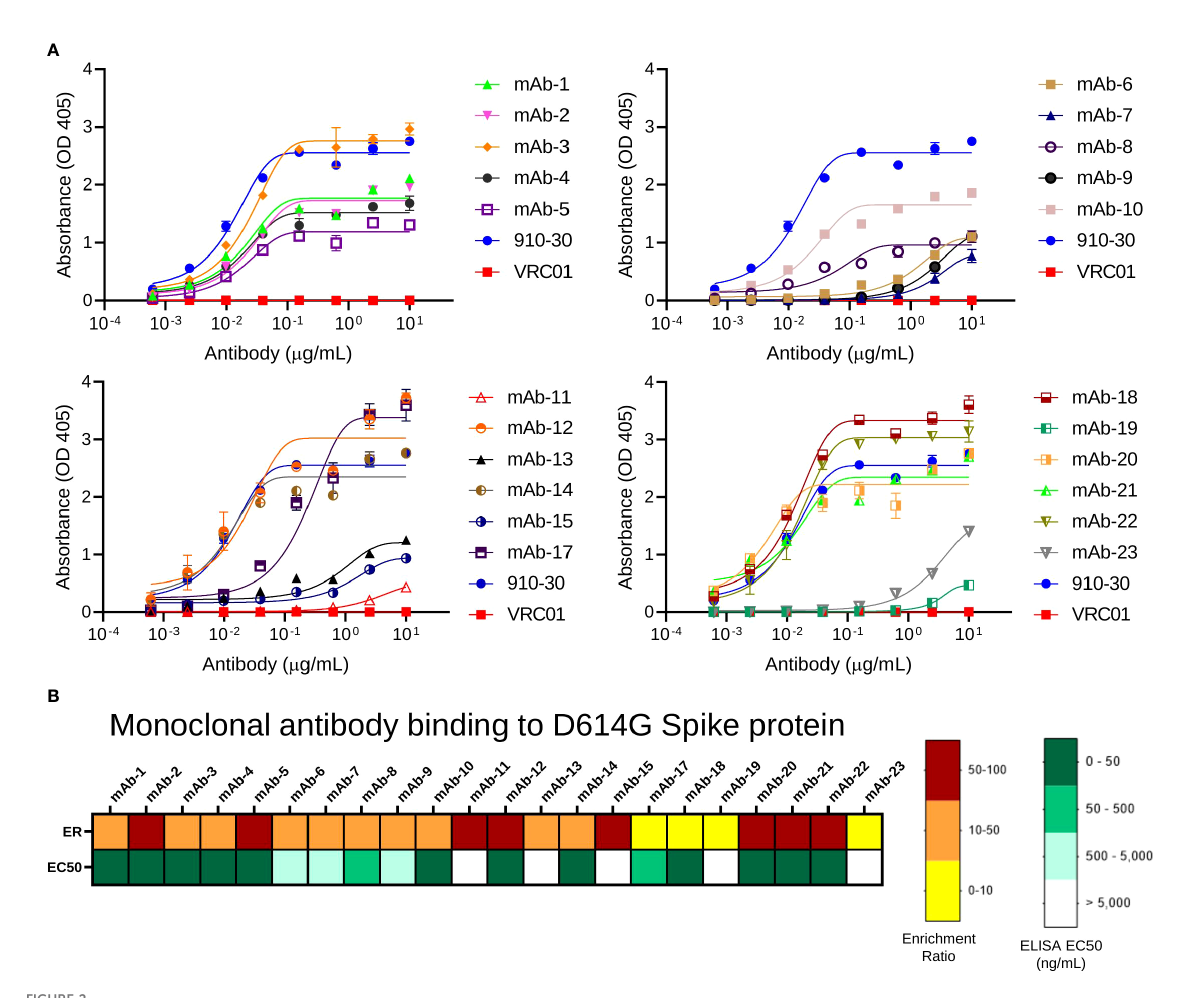
FIGURE 2 Validation of predicted antibody clones by ELISA. (A) ELISA absorbance pro fi les of expressed IgGs to SARS-CoV-2 D614G S2P protein. Data are represented as mean ± SEM. (B) Comparison between ELISA EC 50 value and ER for anti-SARS-CoV-2 mAbs against SARS-CoV-2 D614G